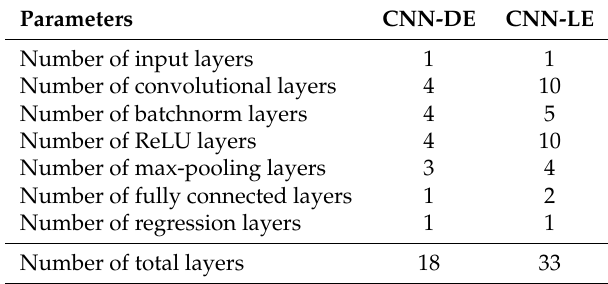
Table 3. CNN model parameters.